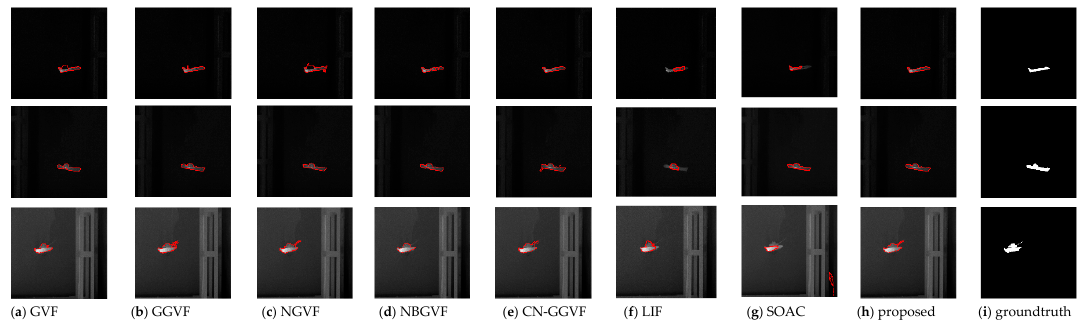
Figure 12. Segmentation results of the images corrupted with salt–pepper noises.